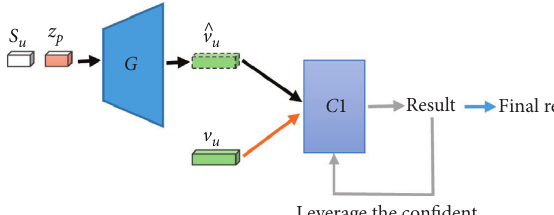
Figure 5: The test process of our method for ZSL: firstly, we use the learned generator to synthesize the visual features of unseen cat- egories conditioned on semantic embeddings; then, we train the classifier by utilizing these synthesized visual features; finally, the real unseen samples are used for testing. The test part is divided into two steps, the first step is rough classification, and then the second step is to fine-tune the classifier by using the confident classification results in the first